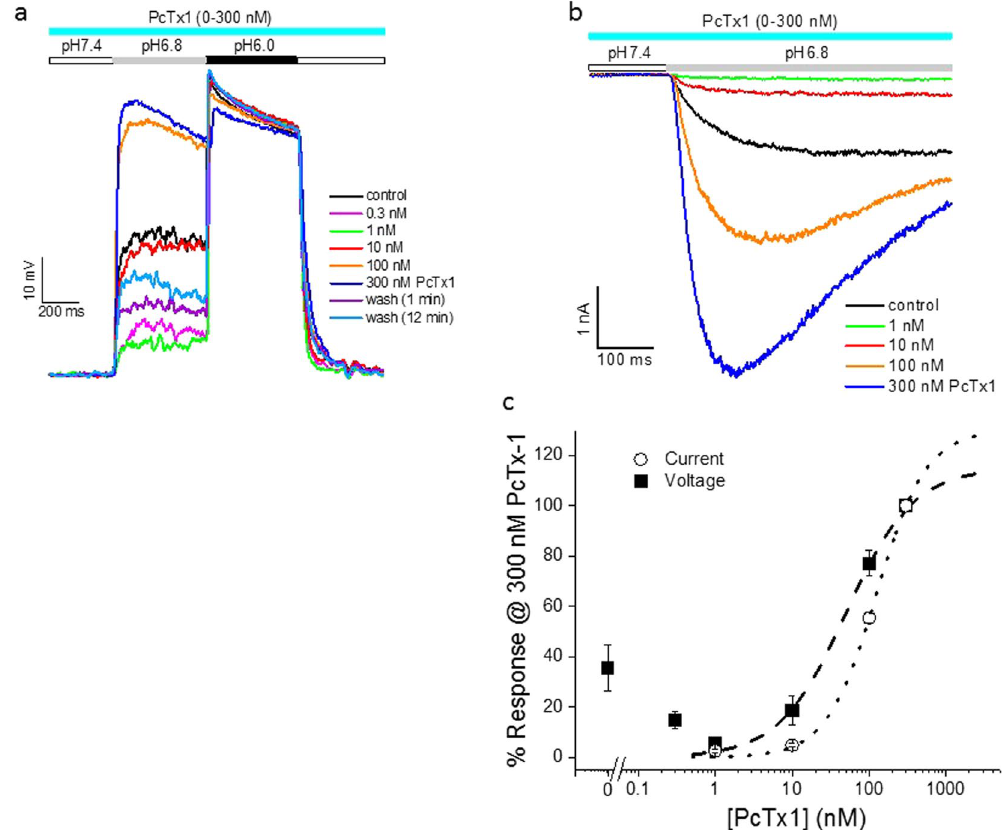
Figure 2. Potentiation by PcTx1 of ASIC1a/2a stably expressed in CHO cells. ( a ) Traces of pH6.8- and pH6.0- induced membrane depolarization from a single cell in the absence and presence of 0.3–300 nM PcTx1. PcTx1 was continuously applied in the order of increasing concentration till reaching steady state at each concentration. Note that the decrease in pH6.8-induced depolarization in the presence of 0.3 nM and 1 nM PcTx1 was reversed by 10–300 nM PcTx1. ( b ) Current traces from a single cell showing inhibition by 1 nM PcTx1 and potentiation by 10–300 nM PcTx1 of pH6.8-induced current responses. ( c ) Average % change in the amplitude of pH6.8-induced depolarization (solid squares; n = 7) and peak current (open circles; n = 6) as a function of PcTx1 concentration. Data were normalized to the value at 300 nM PcTx1 for each cell before averaging. Only data between 1 nM and 300 nM PcTx1 were used for curve fitting (dashed and dotted lines). IC 50 values from the fits are 56.1 nM (depolarization) and 123.9 nM (current), respectively. The conditioning pH was 7.4 for all the experiments shown in Fig.